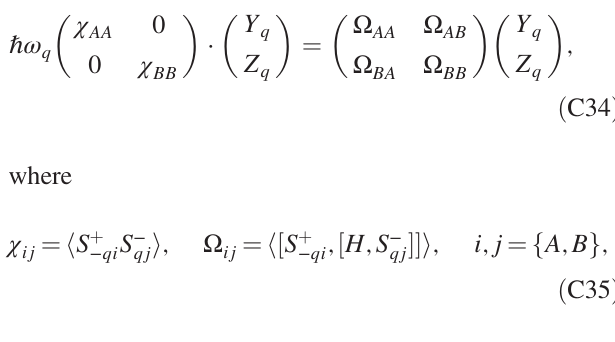
FIG. 10. The energy E of the four spin-flip collective modes in the N ¼ 0 , 1 LL with the cyclotron energy (a) ℏ ω . The Zeeman energy is not included since it only produces a constant shift of all these dispersions. The line color stands for (b) e 2 = ϵ l B the overlap between the normal modes j ψ and the single magnon wave function ansatz S − q i Larmor mode. (c) The low-energy dispersion of the lowest mode in (a). Here we include the Zeeman energy. (d) The phase space of magnon transmission in the incident angle-energy plane. When the incident angle from ν ¼ 2 QHF onto the ν ¼ 1 QHF becomes large, they become evanescent in the ν ¼ 1